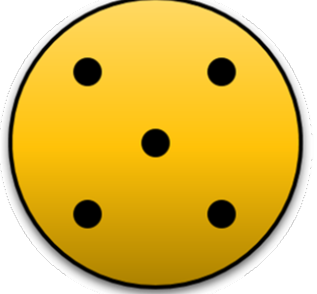
Figure 2. Shore A hardness probing sites along the sample